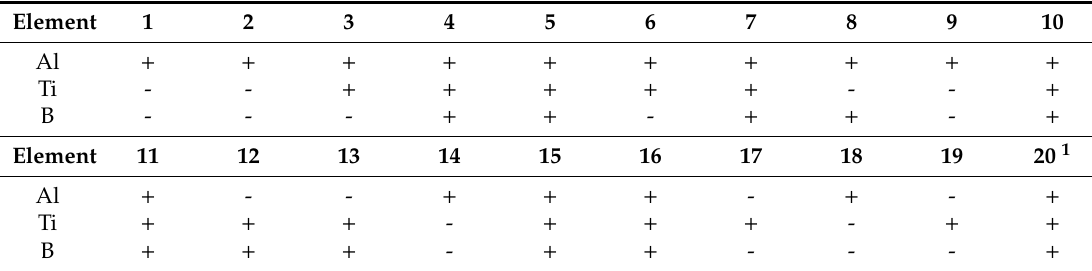
Table 2. Quantitative elemental analysis of Al-Ti-B powder particles before planetary milling (« + »discovered, «-» not discovered).